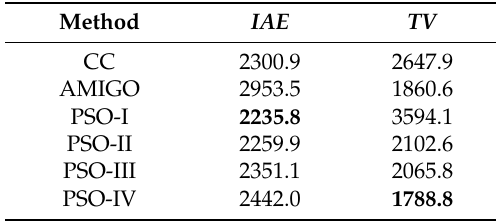
Table 4. TCLab physical results obtained for the several methods considering the time interval [95–620 s]. The best results are represented in